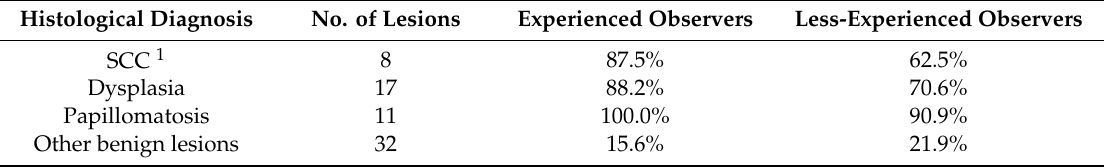
Proportions (values averaged over observers) of reported PVC-positive lesions in di ff erent groups of histological diagnoses, according to the evaluations of experienced and less-experienced